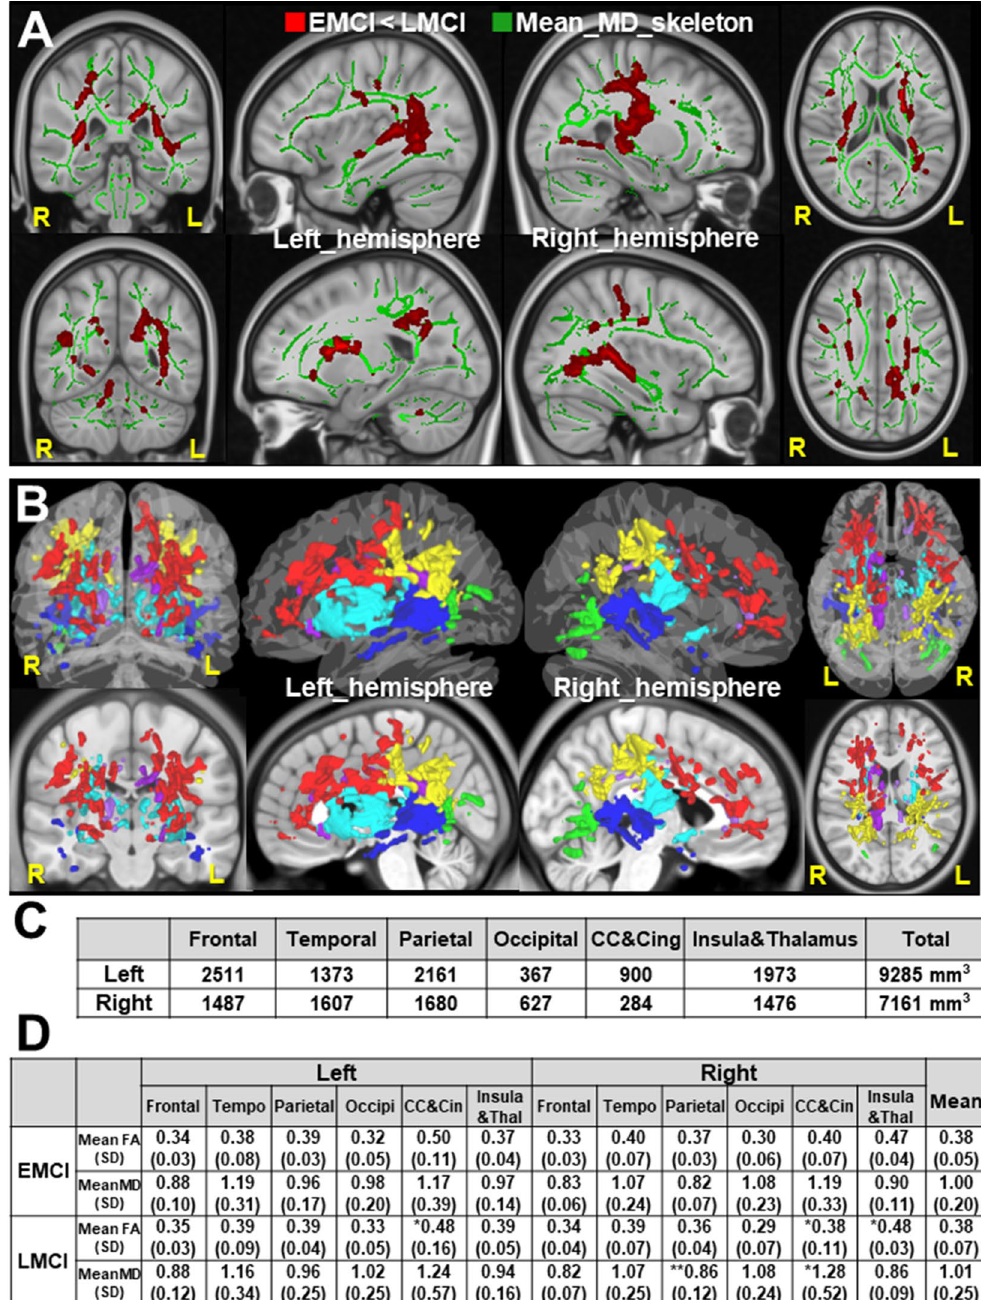
Figure 3. MD-based TBSS and Altered white matter regions. ( A ) The MD-based TBSS projects all subjects’ MD data onto a mean MD tract skeleton before applying voxelwise cross-subject statistics (EMCI vs. LMCI). The registered average subjects’MD tract skeleton is represented in green, while LMCI-related white matter changes were represented in red color. The MD tract skeleton was overlaid on the coronal, sagittal, and axial T1-weighted MRI image (ICBM average brain). Left; coronal view, Middle; sagittal view of left and right hemisphere, Right; axial view. Significance level was p < 0.05 (Threshold Free Cluster Enhancement and Family-Wise Error corrected). ( B ) The LMCI-related white matter changes, identified by MD-based TBSS (EMCI vs. LMCI), were shown overlaid on the 3D glass average brain (upper images) and T1-weighted MRI image (lower images), respectively. The regions in the frontal, parietal, temporal, occipital lobe, Corpus Callosum (CC) and cingulum, and insula and thalamus regions were shown in red, yellow, blue, green, purple, and sky blue respectively. ( C ) The table shows the total volume (mm 3 ) for LMCI-related white matter changes in each hemisphere by MD-based TBSS, which were sub-classed into frontal, temporal, parietal, occipital lobe, Corpus Callosum (CC) and cingulum (Cing), and insula and thalamus regions. ( D ) The table show mean diffusion parameters (mean FA and MD) in each ROI for LMCI-related white matter changes, which were sub-classed into frontal, temporal, parietal, occipital lobe, Corpus Callosum (CC) and cingulum (Cin), and insula and thalamus regions. * p < 0.1, ** p < 0.05 (EMCI vs. LMCI, t -test). Statistical data are in Supplementary Fig. S3. FA fractional anisotropy, MD mean diffusivity, TBSS Tract-based spatial statistics, CC Corpus Callosum, MCI mild cognitive impairment, EMCI early MCI, LMCI late